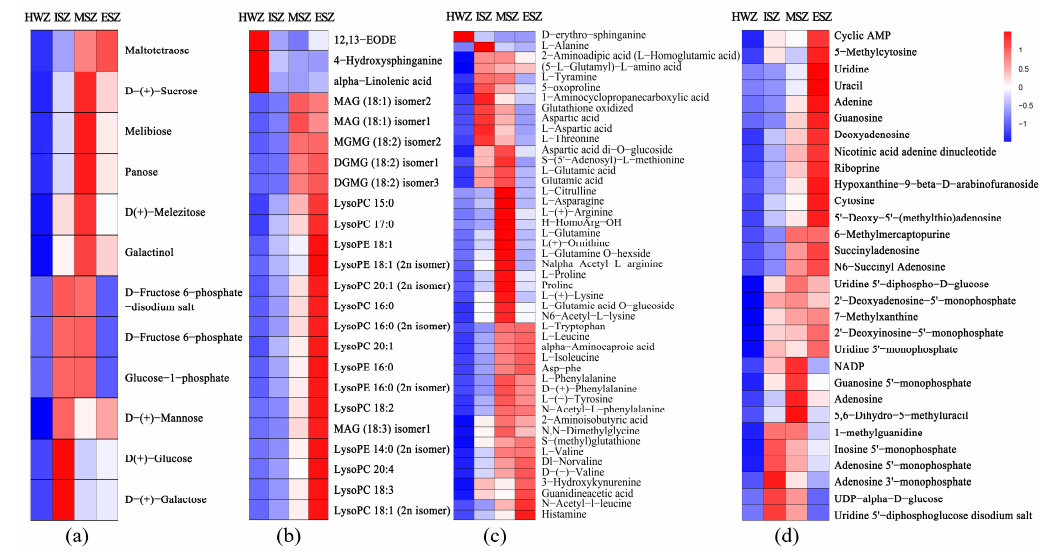
Figure 5. The differential primary metabolites analysis between ISZ, MSZ, ESZ, and HWZ. ( a ) carbohydrates, ( b ) amino acids, ( c ) lipids, and ( d ) nucleotides. Ratios of fold changes are given by shades of red or blue colors. Data represent mean values of three biological replicates for each sample.